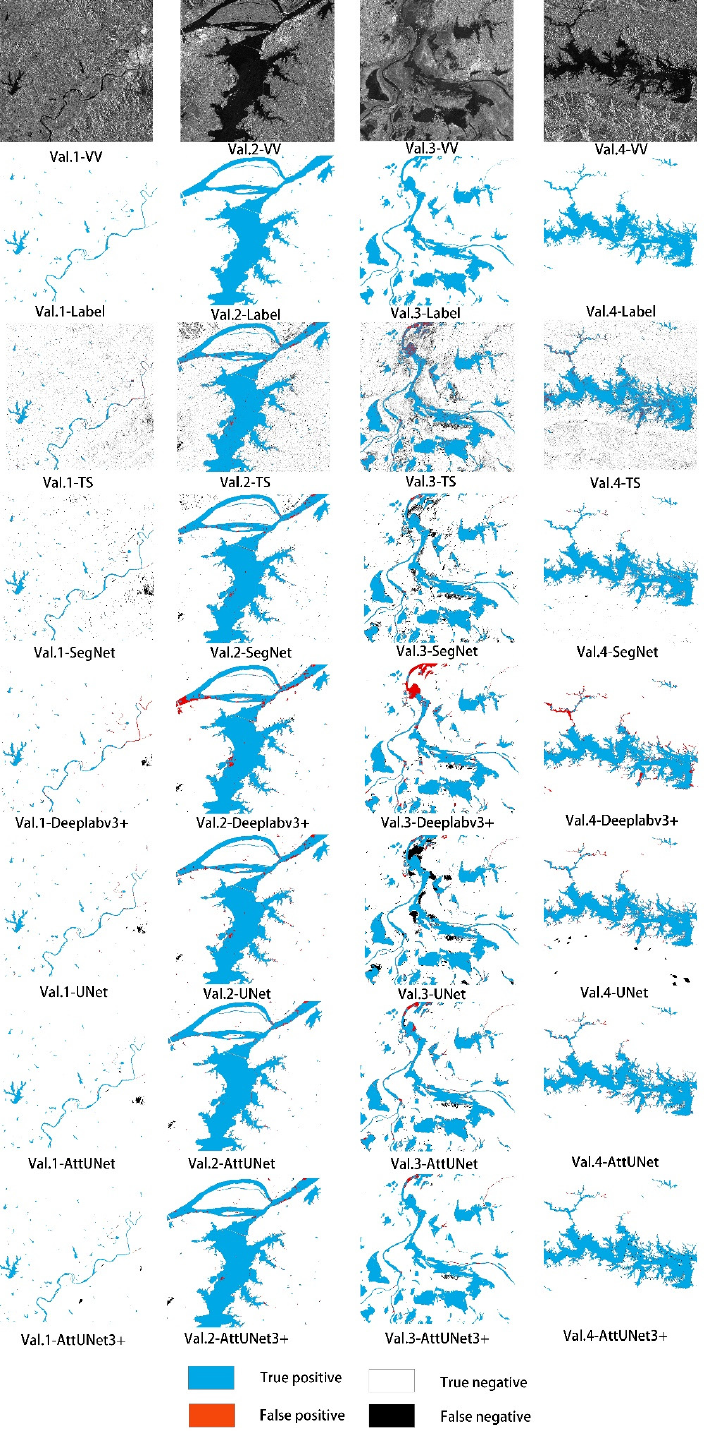
Figure 12. Comparison of experimental results. Val. 1–4 represent four different validation samples.